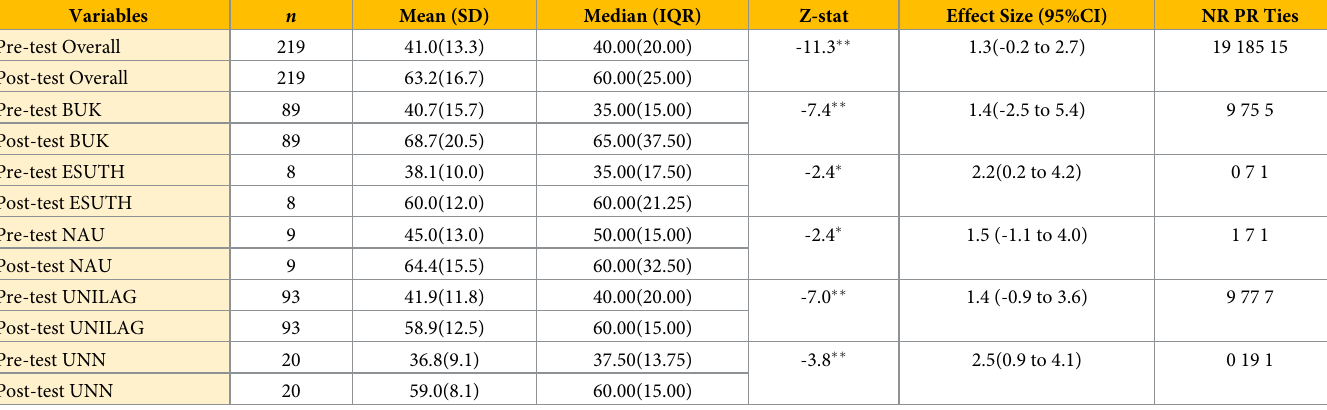
Table 3. Wilcoxon test to explore effect of module on student’s pain management knowledge.